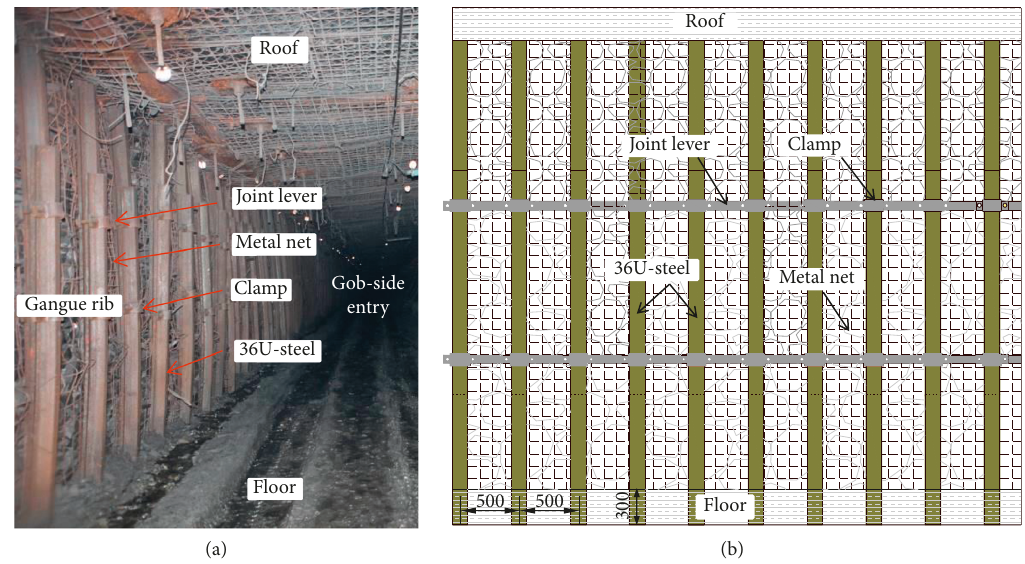
Figure 6: Gangue prevention support: (a) in situ schematic; (b) design schematic.